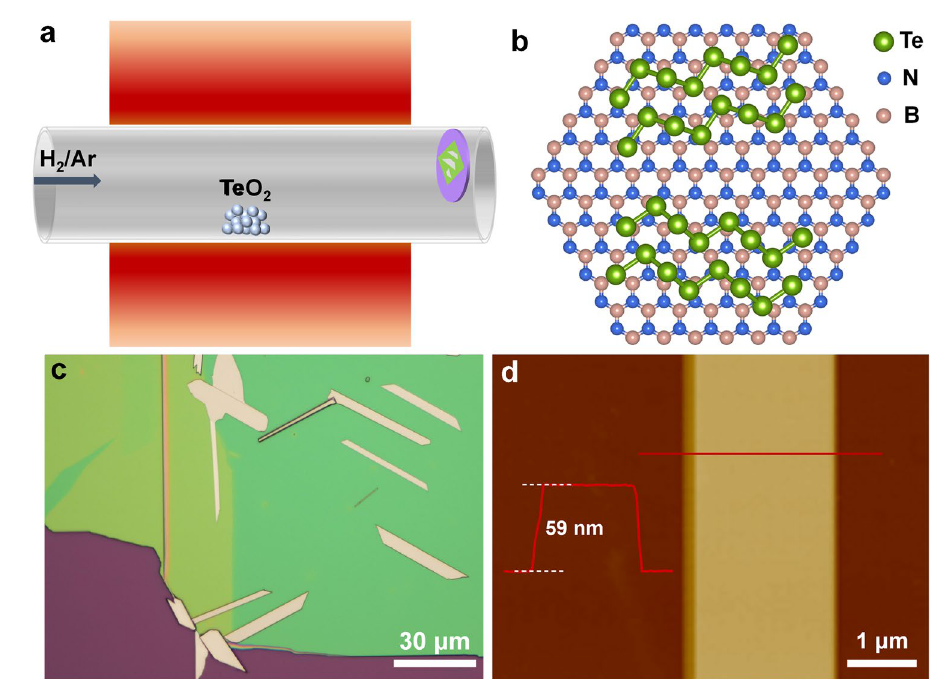
Fig. 1 a Schematic illustration of the growth of Te nanobelts. b Schematic illustration of Te crystal structure on h‑BN crystal structure in a top view. c Typical optical image of Te nanobelts grown on h‑BN. d AFM image of a typical Te nanobelt with thickness of 59 nm, the inset shows the height profile corresponding to the red line across the